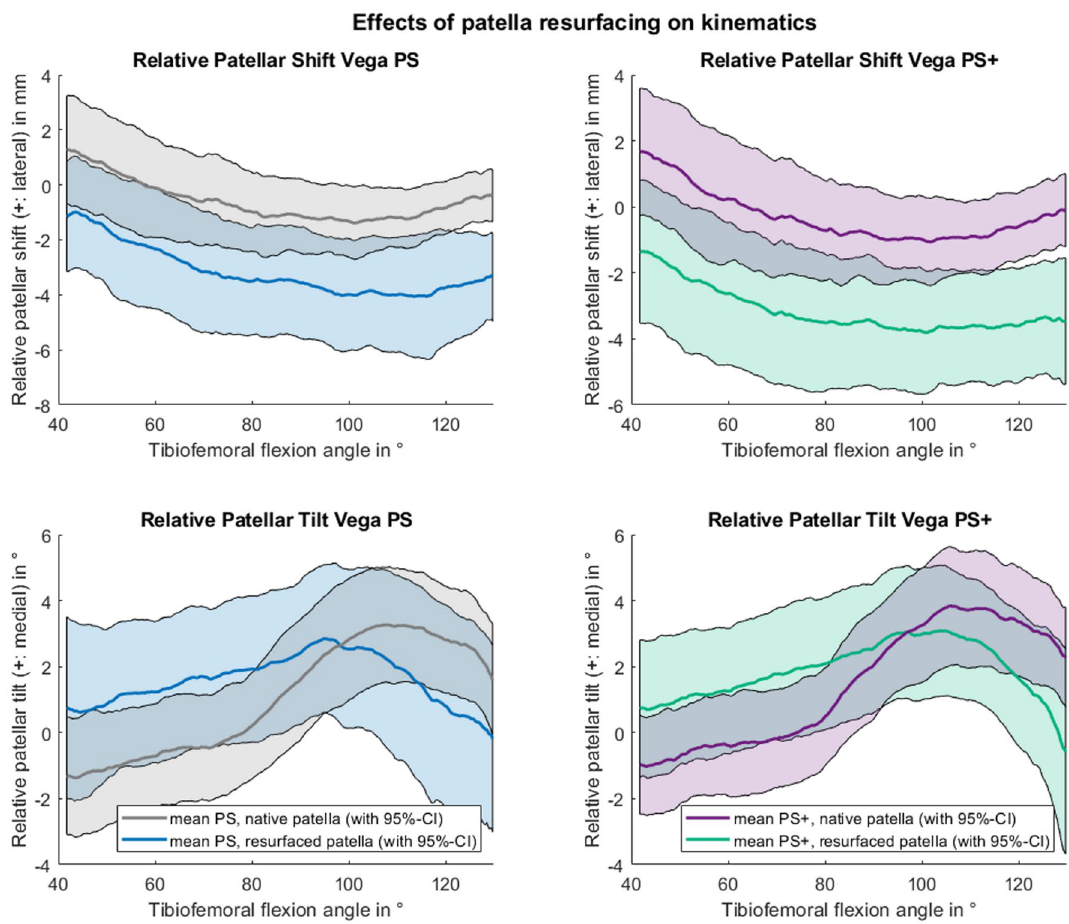
Figure 3. Differences to the native situation for patellar shift (top) and tilt (lower) with Vega PS (left) and PS+ (right) inserts for native (grey/purple) and resurfaced patella